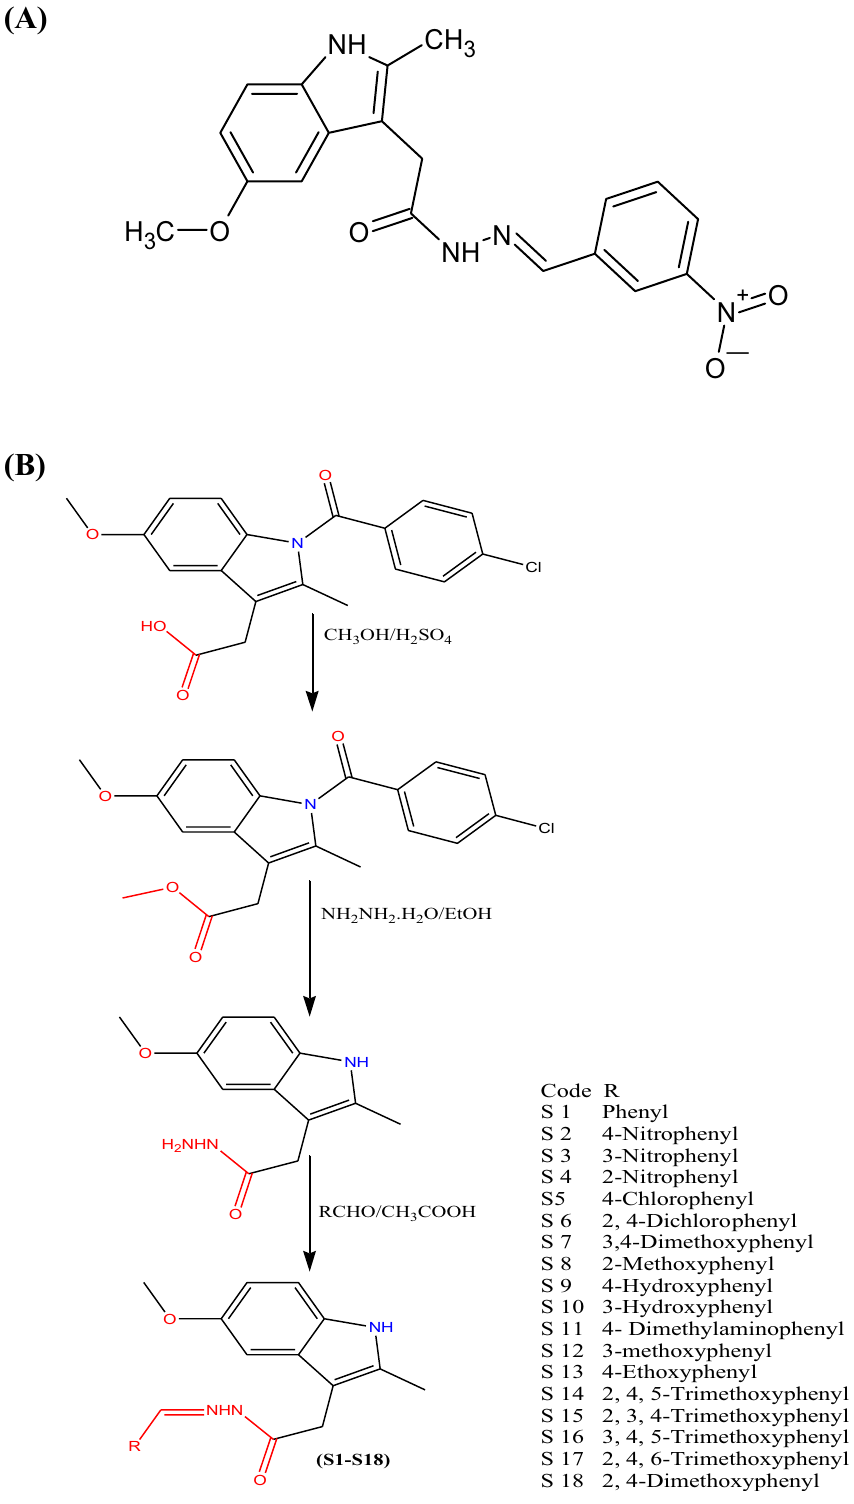
Figure 1. ( A ) Structure of a novel indole derivative, 2-(5-methoxy-2-methyl-1H-indol-3-yl)-N’-[(E)-(3- nitrophenyl) methylidene] acetohydrazide (MMINA). ( B ) Scheme